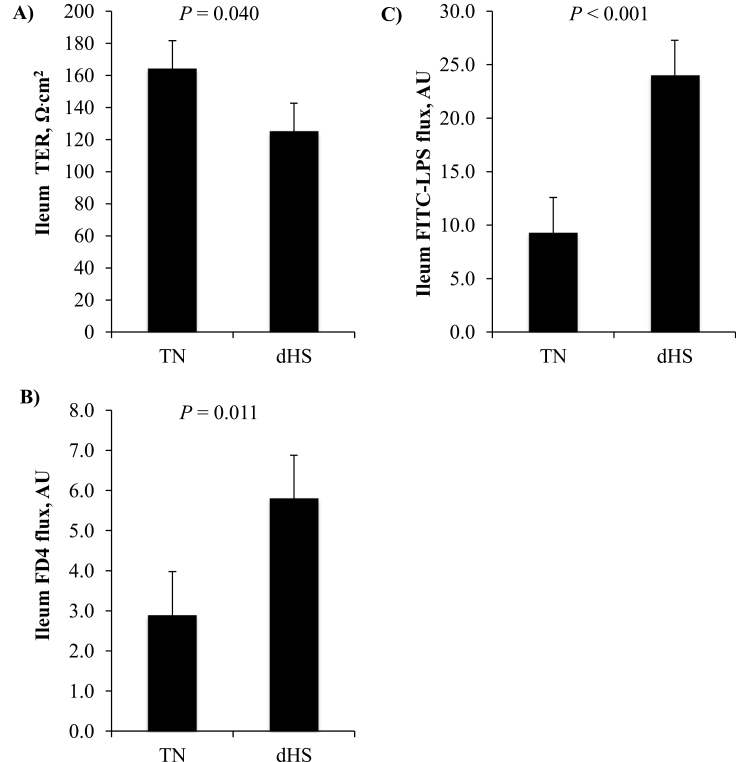
The effect of dHS or TN conditions on ileum integrity. (A) TER, (B) FITC–dextran 4.4 kDa (FD4) flux, and (C) FITC–LPS flux. Pigs (n = 24) were dHS (6 h at 38°C, 40–60% humidity followed by 18 h at 32°C, 40–60% humidity) for 3 d or reared under constant TN (28°C; 40–60% humidity; n = 24 pigs). Ileum segments were assessed for integrity in modified Ussing chambers ex vivo.